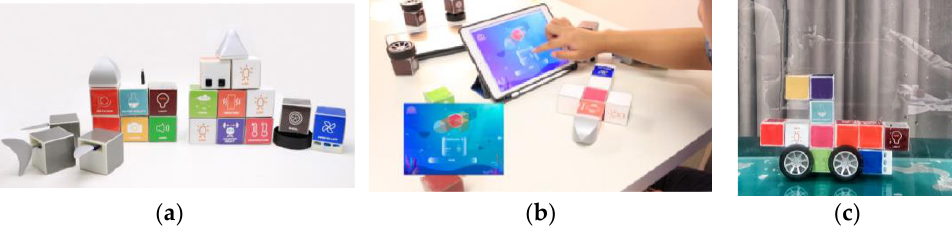
Figure 26. Sensor, actuator and shape modules ( a ), programming and controlling modules ( b ), construction of underwater vehicle ( c ) [44].